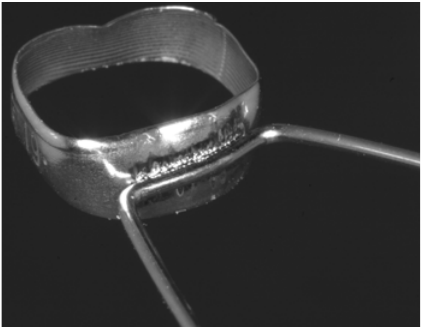
FIGURE 5- Band-to-wire joints. Wire material: Forestanit in spring hard quality (diameter 0.9 mm; length 7 mm). Band material: Dura-Fit (Forestadent. Germany)